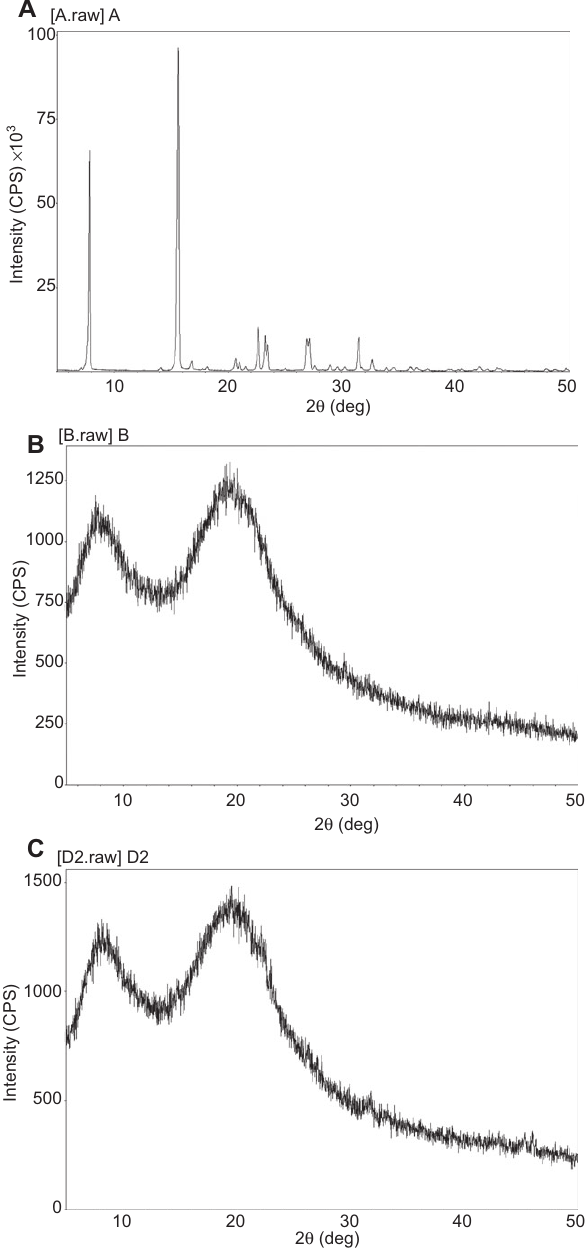
Figure 8 X-ray diffraction pattern of (A) pure aspirin, (B) blank ethyl cellulose microparticles and (C) aspirin-loaded ethyl cellulose